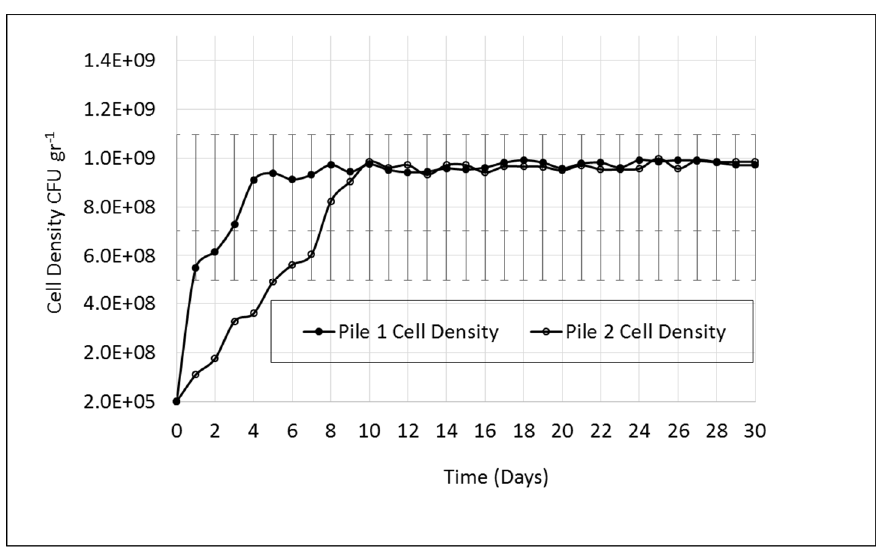
Figure 4. Changes in microbial population during composting.